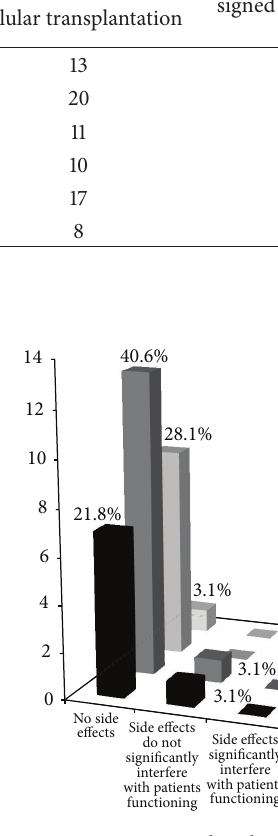
Figure 2: Frequency distribution of the participants on the CGI-III scale. This figure demonstrates the percentage of people on varying degrees of efficacy of the intervention. This takes into consideration the side effects and the benefits